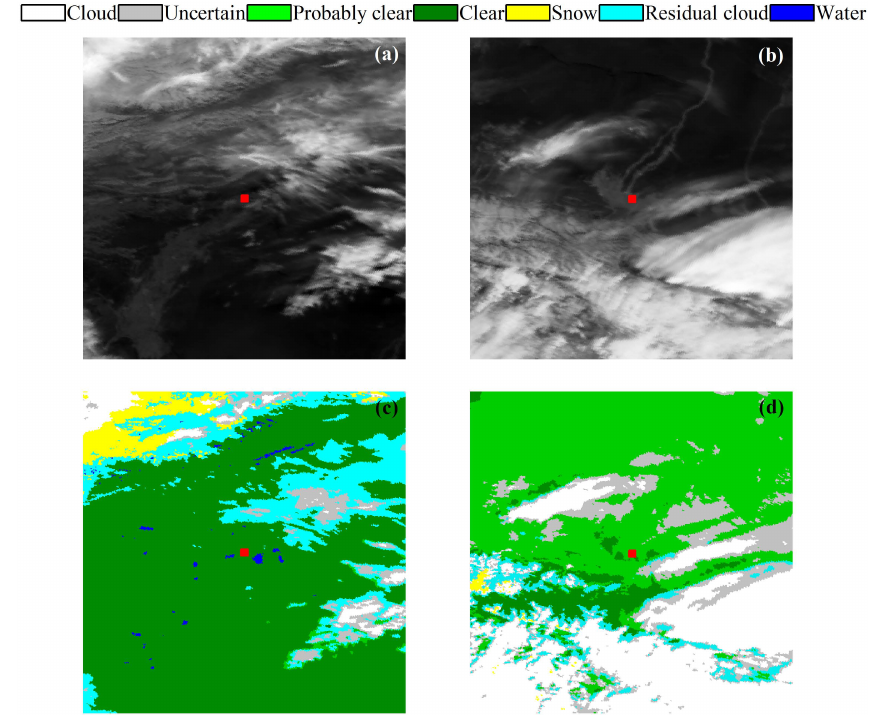
Fig. 9. Two cases with poor correlations for comparisons with ground-based observations centered at the Bachu and Hetian sites. The red rect- angles represent the weather stations; the gray-scale images of VIRR channel 4 (10.3–11.3µm) (a) on 24 November 2011 at 06:05:00UTC for the Bachu site and (b) on 16 February 2011 at 06:05:00UTC for the Hetian site; (c) and (d) the corresponding cloud mask results obtained from the algorithm proposed in this